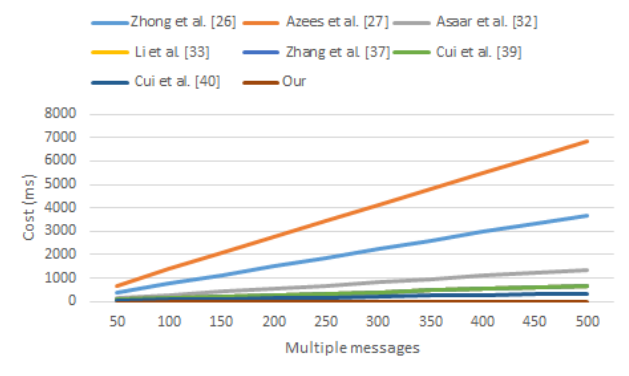
Figure 5. Computation cost in the batch verification of multiple